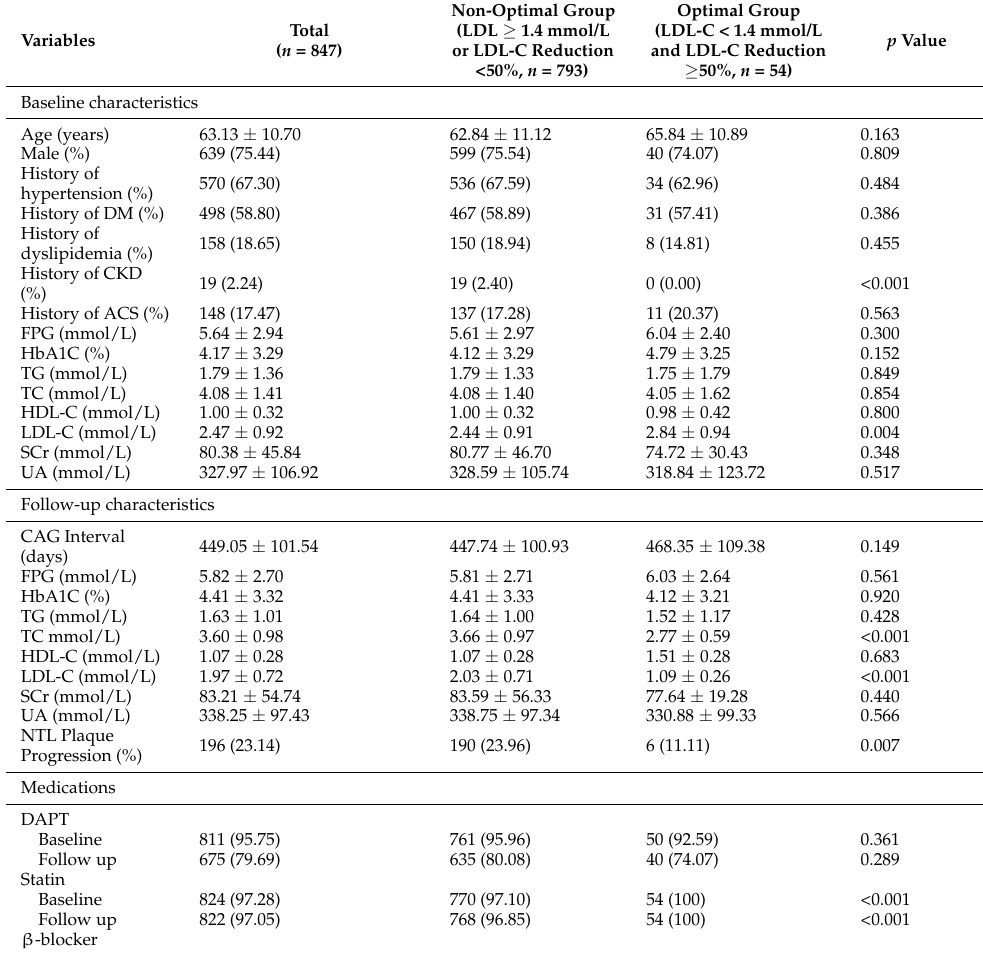
Table 1. Baseline and follow-up characteristics of the study patients according to the follow-up LDL-C